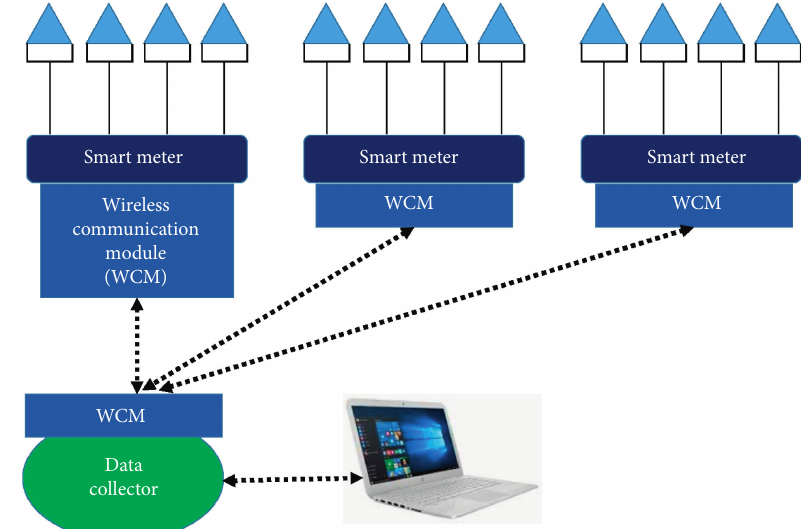
Figure 2: Data collection framework.